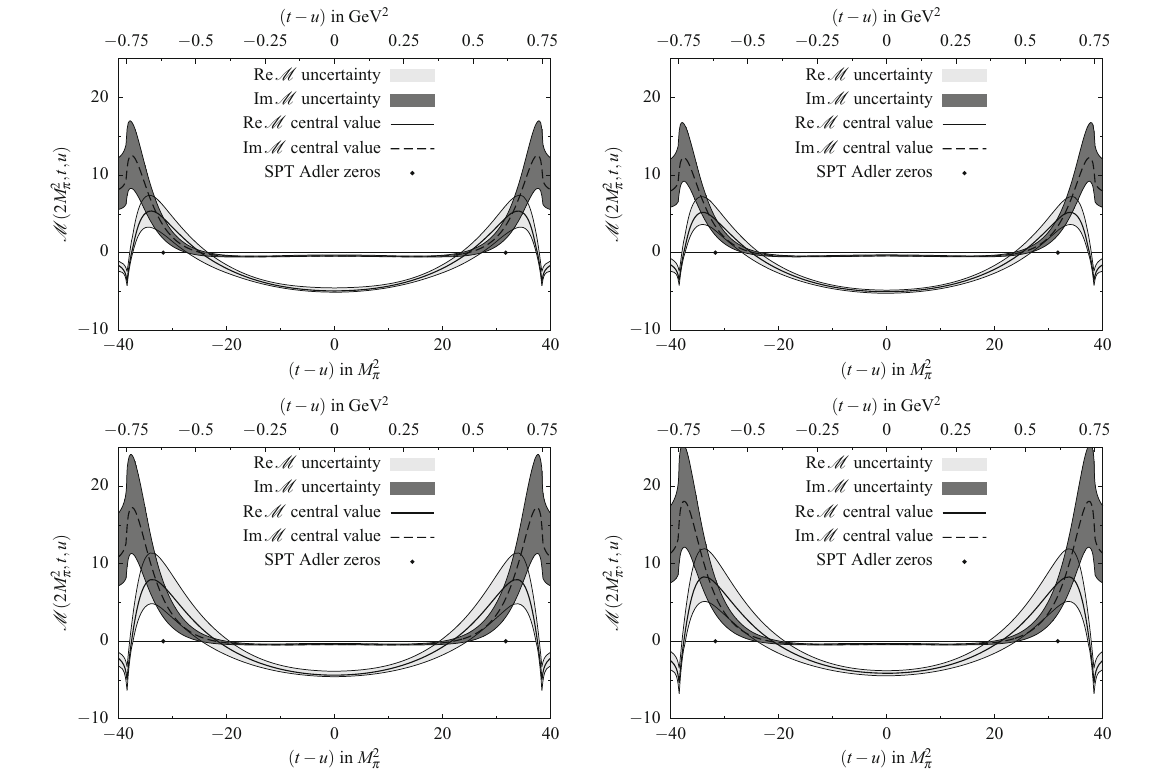
Fig. 8 Real and imaginary part of the amplitude along a line of fixed s = 2 M 2 π . The upper two panels give the fit of the dispersive representation to the BES-III, the lower two panels to the VES data set. The DR 3 ( left column ) and DR 4 fits ( right column ) are